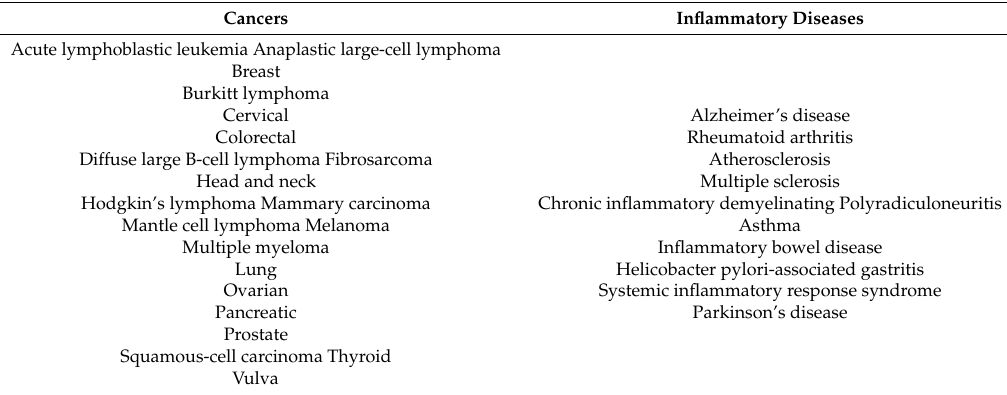
Table 1. The activation of nuclear factor kappa-light-chain-enhancer of activated B cells (NF- κ B) in selected human